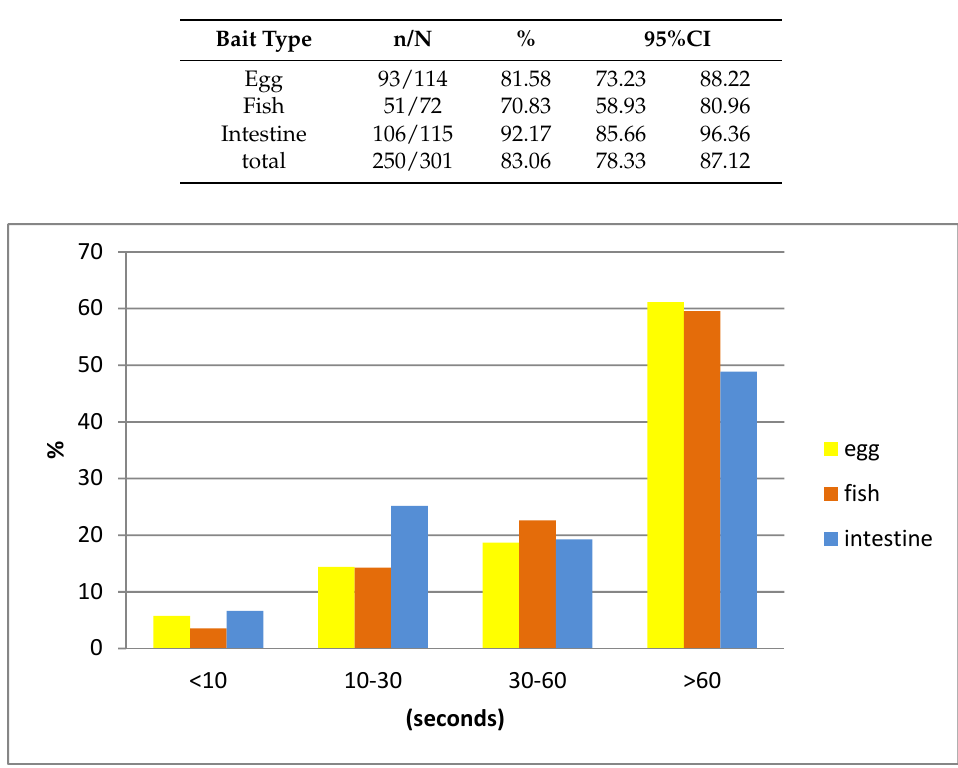
Table 9. Proportion of baits completely consumed (n = number of baits consumed completely, N—number of baits consumed, 95% CI—95% confidence interval).